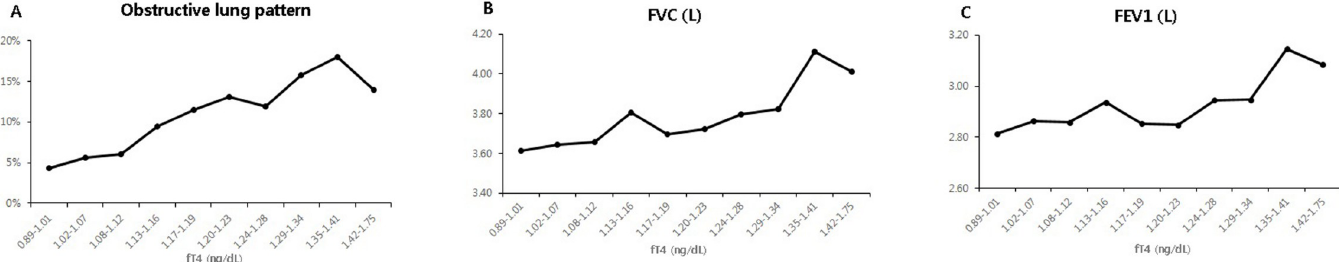
Fig 2. Relationship between free thyroxine (fT4) and lung function. The obstructive lung pattern (A), forced vital capacity (FVC) (B) and forced expiratory volume in one second (FEV1) (C) values tended to increase as fT4 increased.